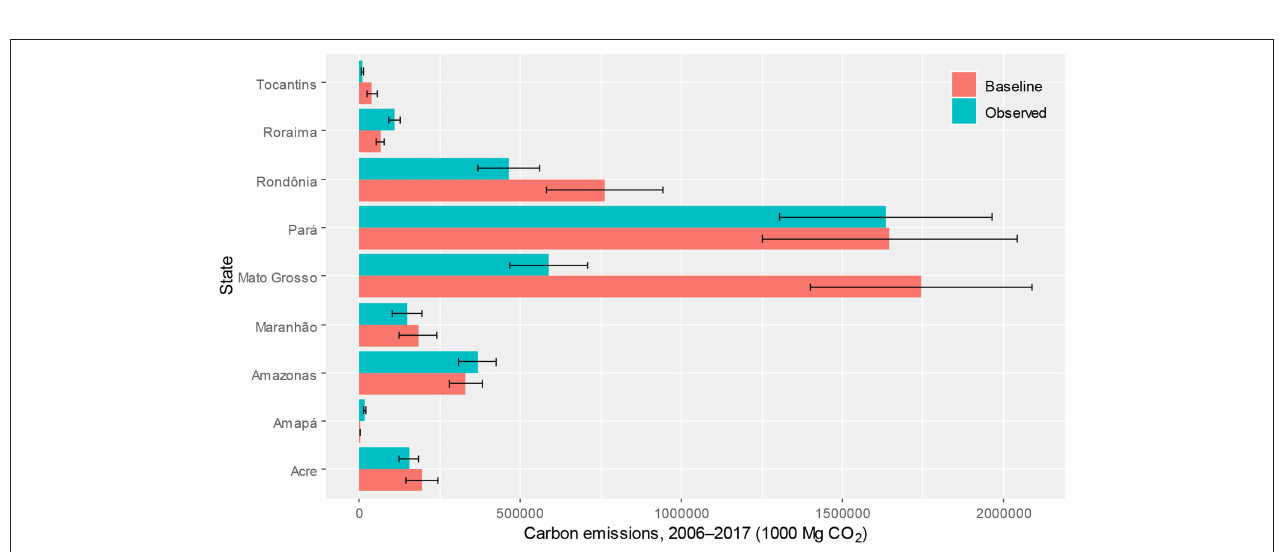
FIGURE 5 | Cumulative baseline and observed carbon emissions from deforestation for the 2006–2017 period in the Amazonian states of Brazil. Error bars represent standard errors computed at the pixel level of the biomass-density maps.